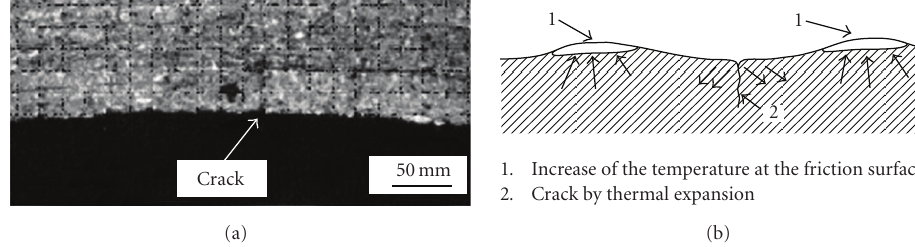
Figure 9: (a) surface of the primary ring crack; (b) crack by thermal dilatation. Parametric conditions of the friction test:carbon 1 (primary ring variant), 5 daN (normal load), dry (surrounding), 3 μ m (mating ring finishing), 400 rad/s (rotational frequency). Temperature maximal measured during the test:473 ◦